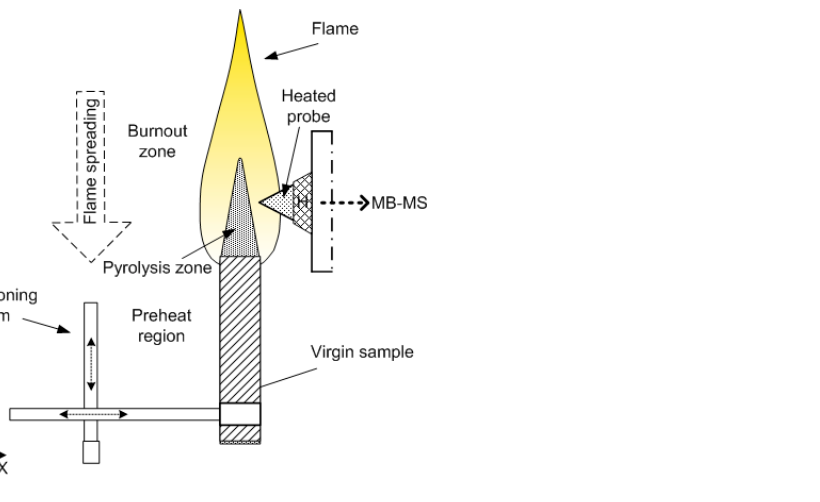
Figure 2. A layout of the experiment for measuring the flame structure using the molecular-beam mass spectrometry (MBMS) method.